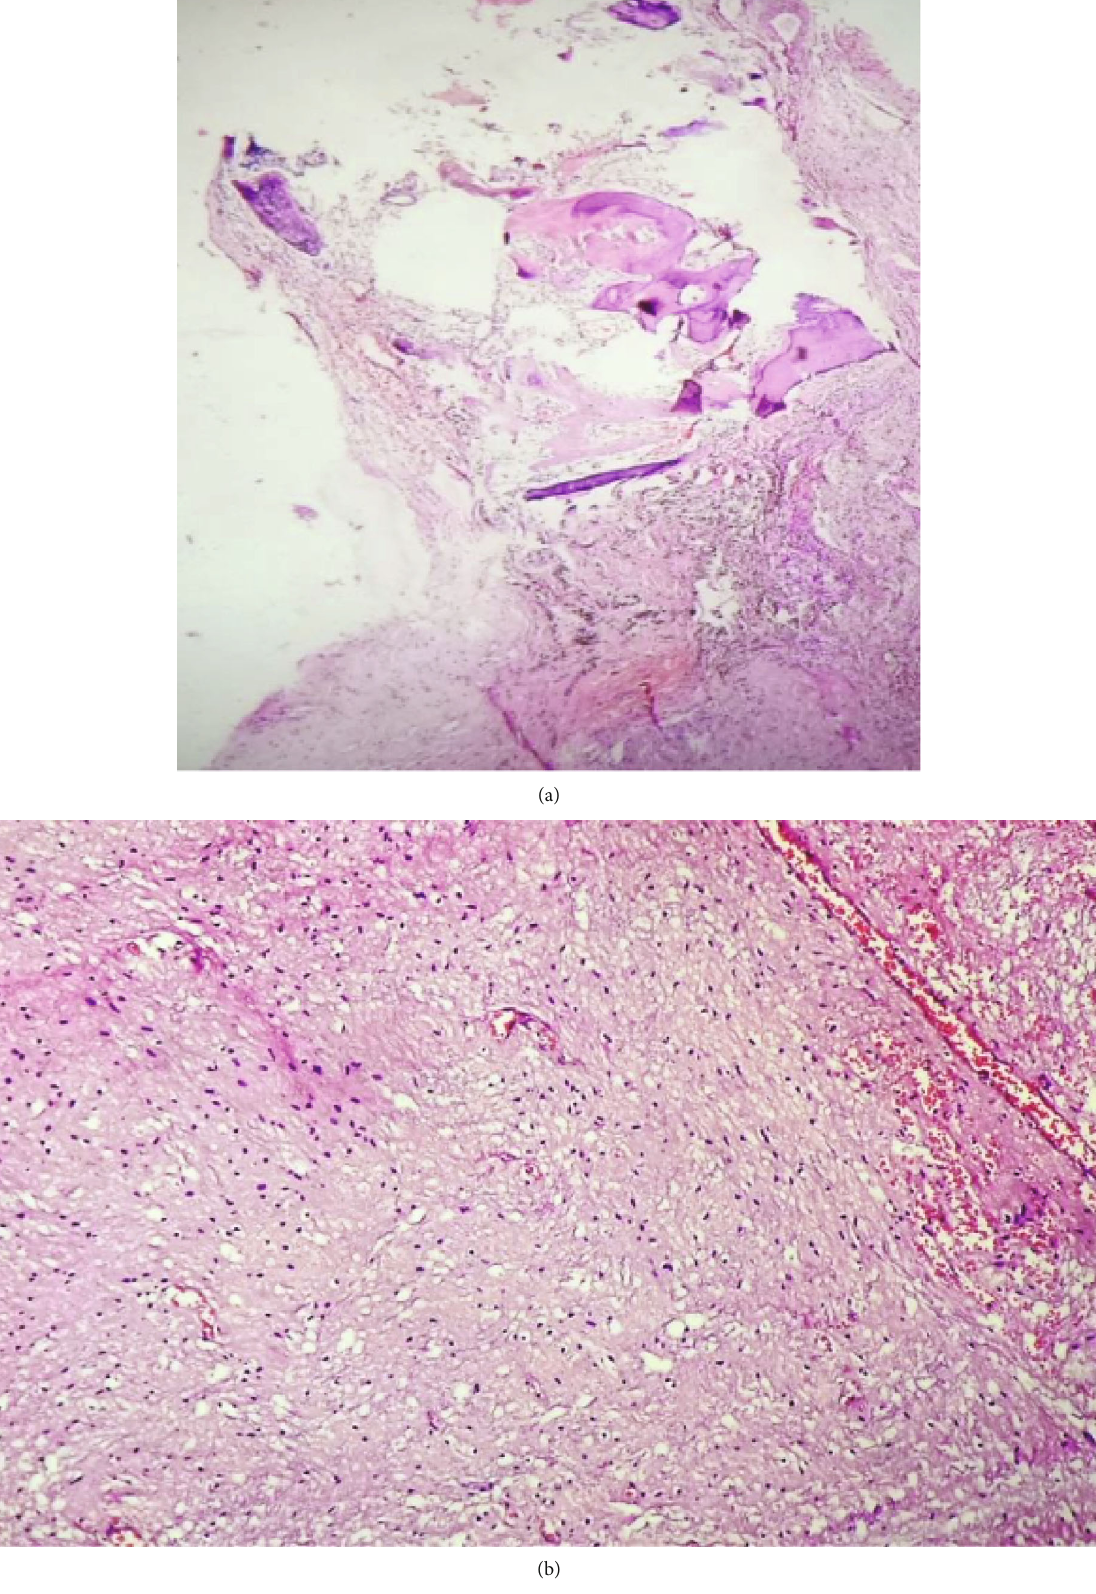
Figure 5: (a) Bony tissue (5x magni fi cation). (b) Glial tissue under (20x magni fi